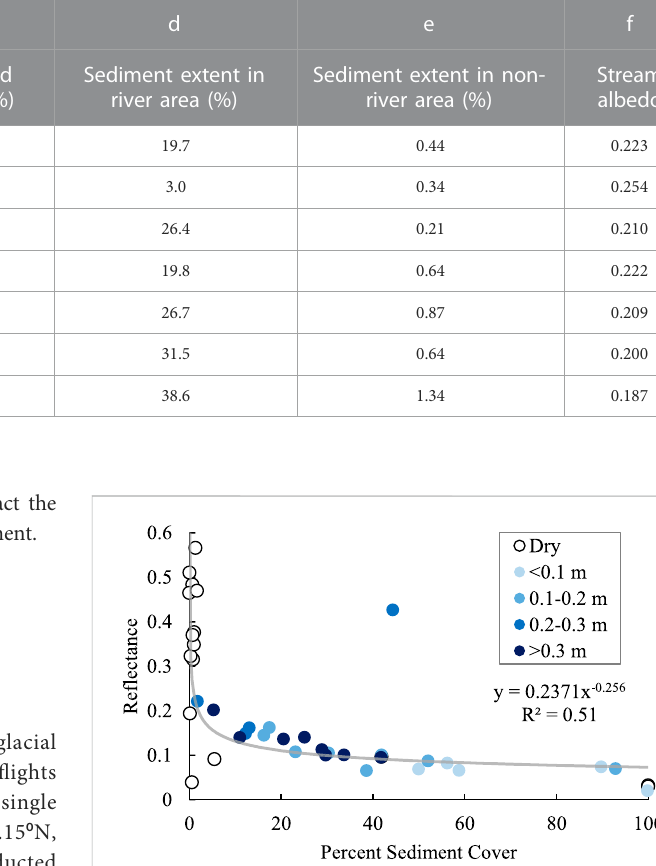
TABLE2StatisticsforthecoverageofthestreamswithintheUAVscenesderivedfrommanuallydigitizedshorelines(b)aswellastherelativecoverageofcleanice (c)andsedimentwithin(d)andoutsideof(e)observedineach fl ightscene.Streamalbedowascalculatedastheweightedaverageofcolumnscanddusingalbedo values of 0.24 and 0.07 respectively.